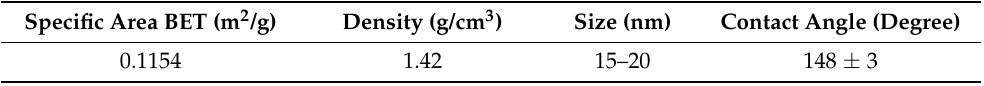
Table 1. Ladder polymethylsilsesquioxane (PMSQ) nanoparticles properties [4].